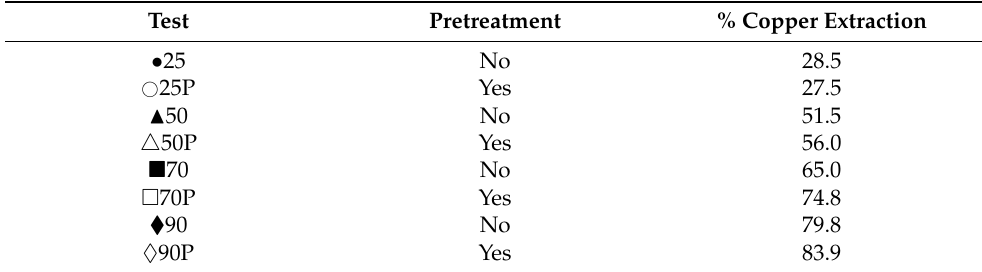
Table 3. Summary of the copper yields obtained via leaching test with and without pretreatment.